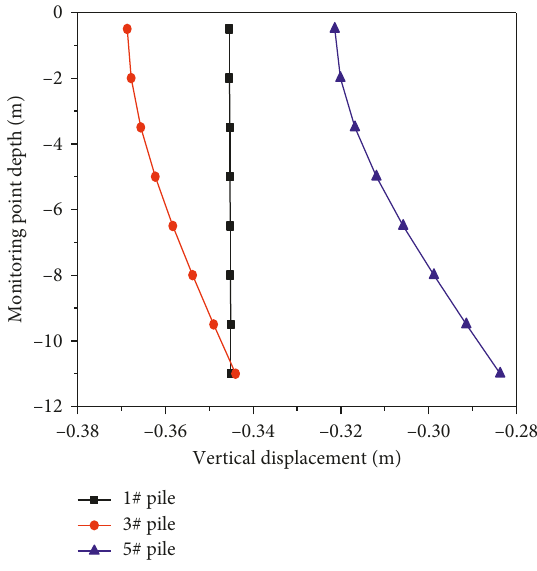
Figure 9: Vertical displacement of the pile.